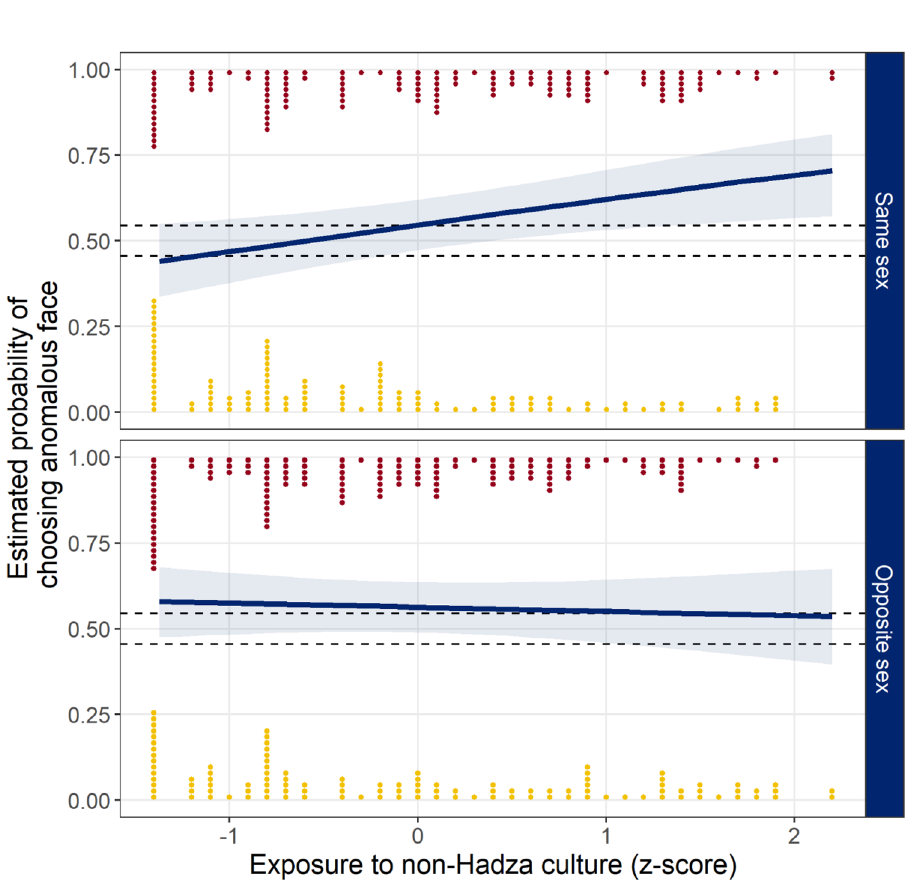
Figure 3. Joint posterior predictions of choosing the anomalous face for good forager judgments by participants’ exposure to non-Hadza culture as a z -score and whether the face was same- or opposite-sex. Lines are the median estimate from the posterior and shaded regions are the 90% highest density intervals (HDI). Points are individual responses (for plotting, exposure values were rounded to the nearest tenth), with red points at the top indicating when the participant chose the anomalous face, and the yellow points at the bottom indicating when the participant chose the non-anomalous face. Dashed lines indicate the region of practical equivalence